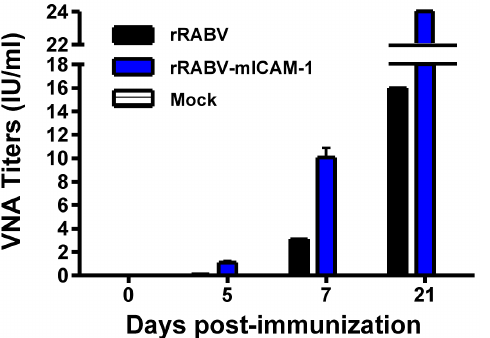
Figure 6. Low-dose rRABV-mICAM-1 induces VNA titers in-vivo more rapidly and in higher quantities than does rRABV. Sera from mice immunized with a single dose 10 3 ffu/mouse with rRABV- mICAM-1 or rRABV were pooled and then VNA titers measured by RFFIT and expressed as International Units (IU/ml). Data represents equal proportions of sera from five mice per